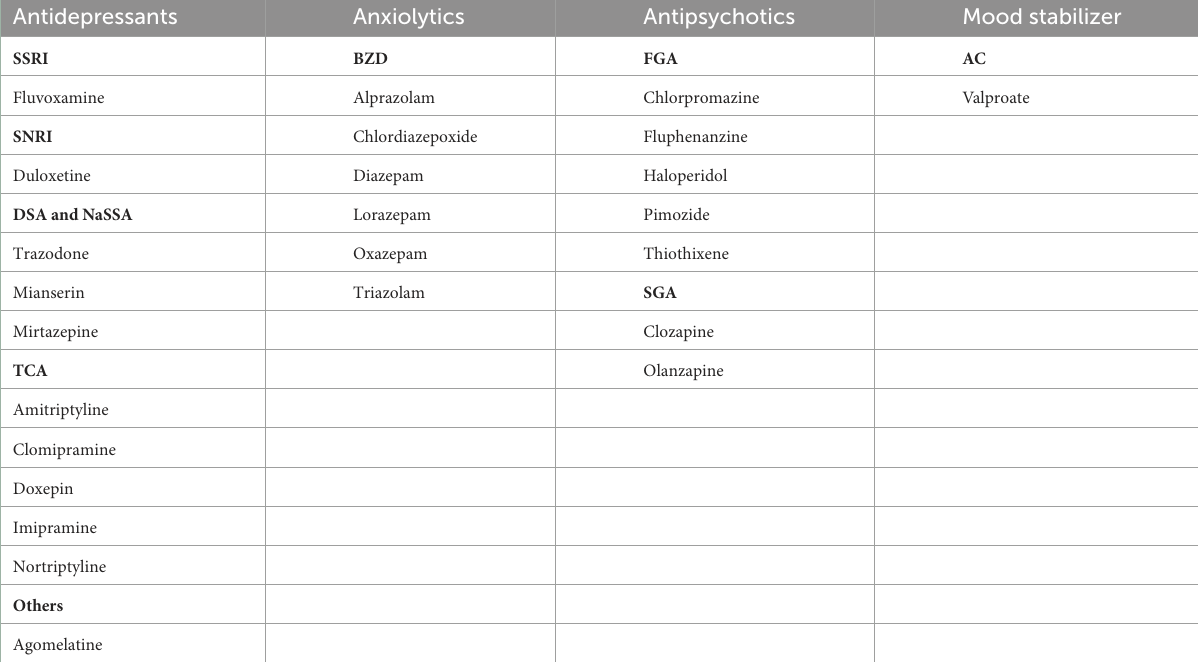
TABLE 1 Polycyclic aromatic hydrocarbons within tobacco smoke induce CYP 1A2 and accelerate metabolism of the listed psychotropic substrates.